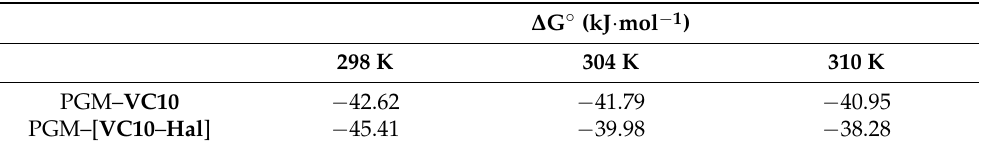
Table 3. The Gibbs free energy variation ( ∆ Gº) for the PGM– VC10 and PGM–[ VC10 – Hal ] systems at different